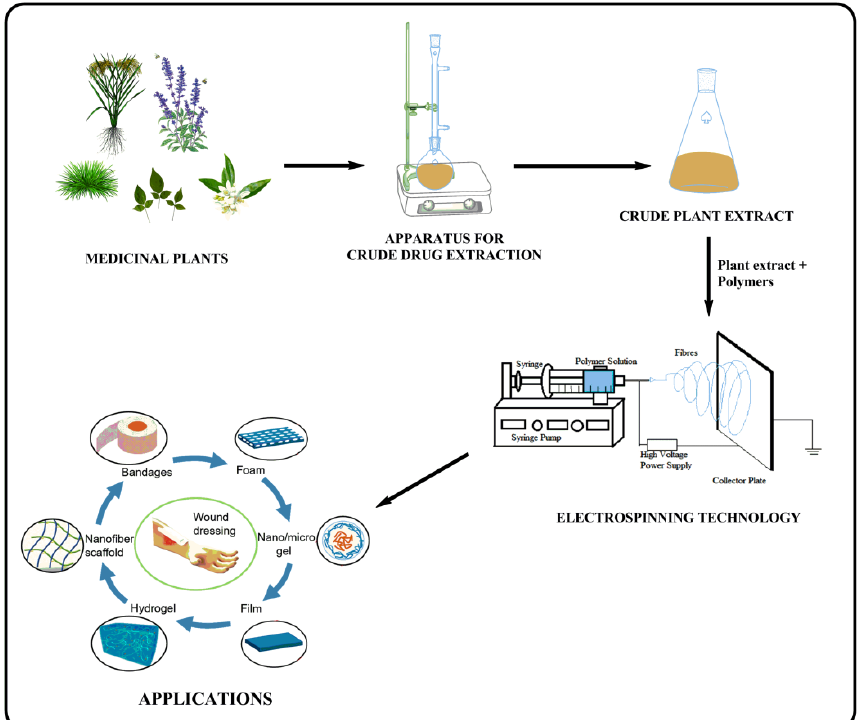
Figure 2. Extraction of phytoconstituents from medicinal plants and fabrication of nanofibrous meshes employing electrospinning and its applications.